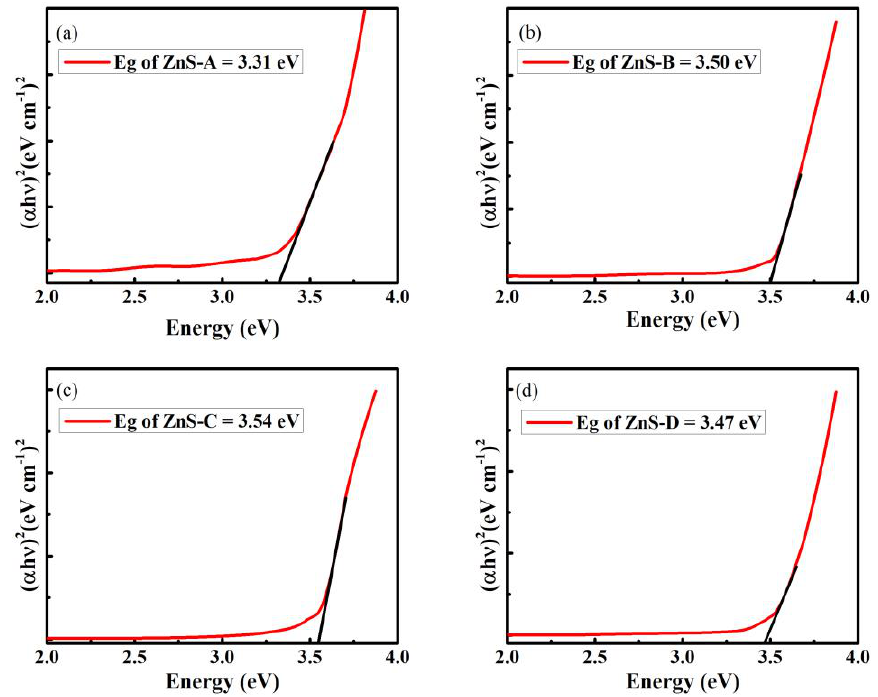
Figure 5. The optical band gap of ( a ) ZnS-A, ( b ) ZnS-B, ( c ) ZnS-C, and ( d ) ZnS-D thin